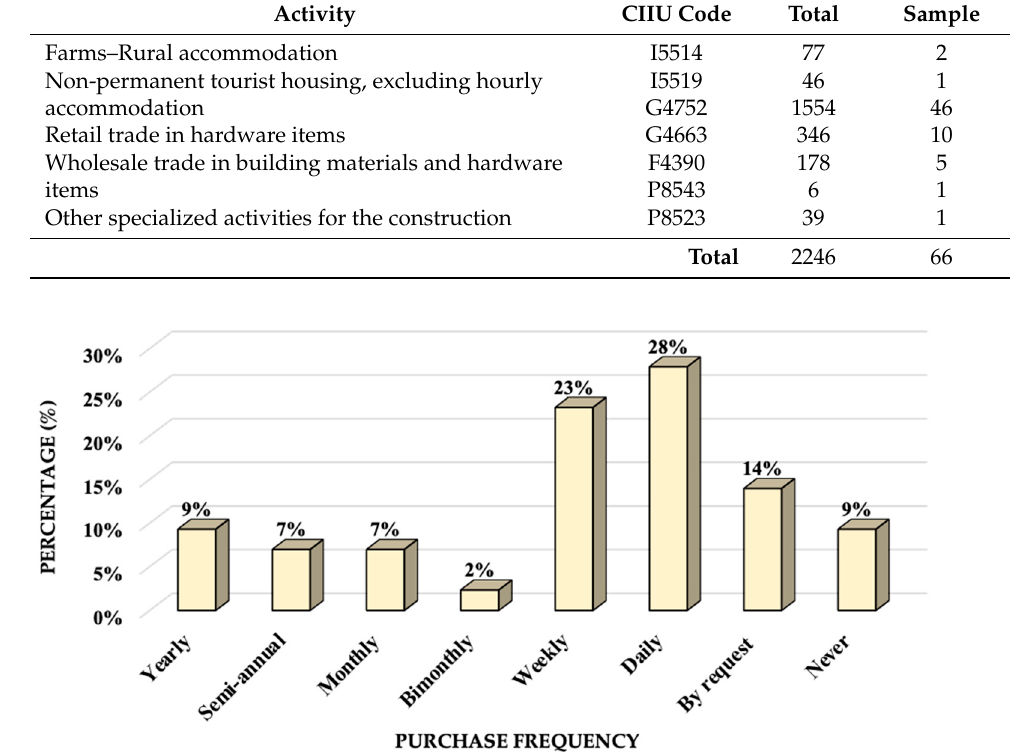
Figure 6. Frequency of purchase of cobbles for pedestrian use or light vehicle traffic.